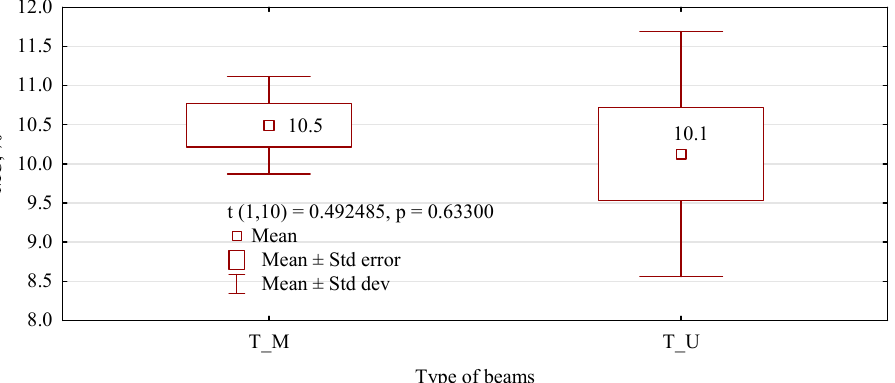
Figure 14. Average moisture content of 6-layer beams determined during the determination of mechanical properties in the bending test. The t -test is a statistical hypothesis test in which the test statistic follows a Student’s t-distribution under the null hypothesis.